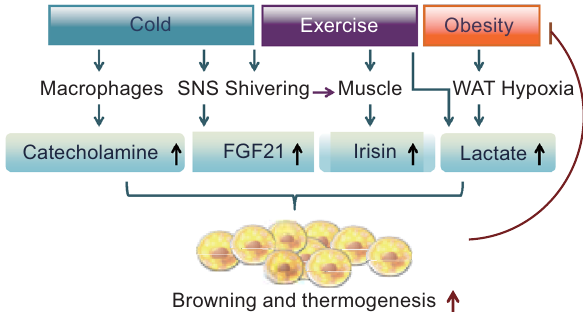
Figure 1. The mechanisms by which cold, exercise, and obesity regulate thermogenesis. Cold exposure could improve browning and thermogenesis of human adipocytes through macrophages, sympathetic nervous system (SNS), and muscle contraction. Cold exposure rapidly promoted alternative activation of adipose tissue resident macrophages, leading to the secretion of cate- cholamines to induce beige fat development and thermo- genesis. Cold activates the SNS, leading to the upregulation of fi broblast growth factor 21 (FGF21). Cold and exercise cause muscle contraction, which stimulates irisin secretion and induces shivering thermogenesis. In response to cold-exposure, the shivering-induced irisin promotes browning and thermogenesis of human adipo- cytes in concert with the SNS-induced FGF21. Exercise is also able to promote browning and thermogenesis by increasing lactate production. In obese individuals, enhanced lactate in adipocytes promotes browning and thermogenesis of neighboring adipocytes, which in turn, limits the accumulation of fat, thereby impeding the development of